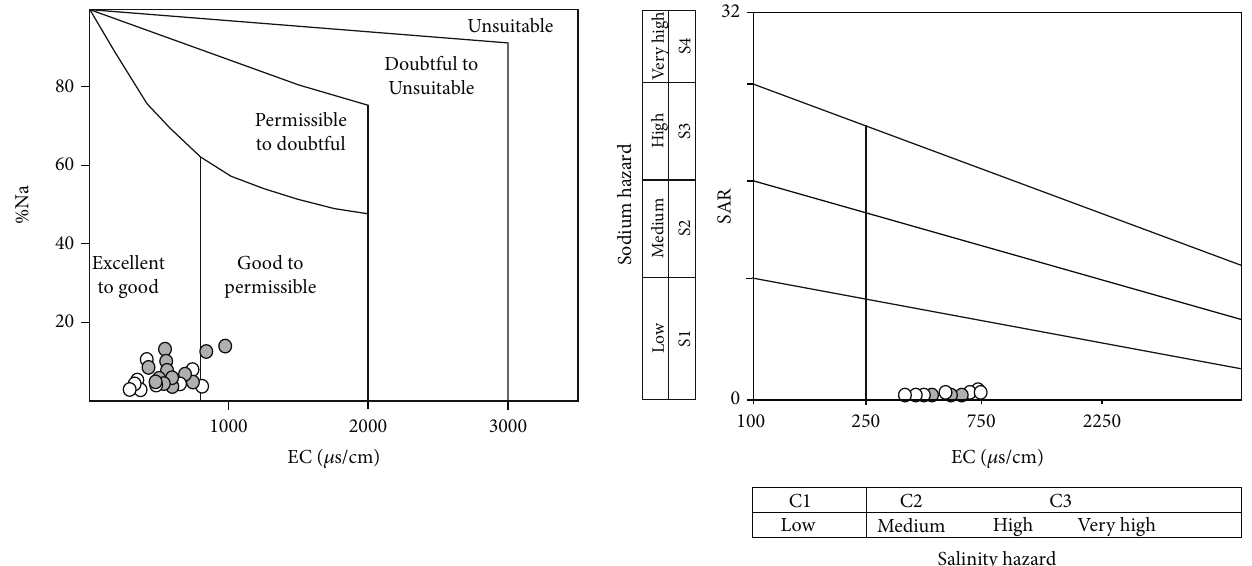
Figure 12: Plots of calculated values of %Na and SAR vs. EC of groundwater samples (after Wilcox [53] and [26], respectively). The symbols are as Figure